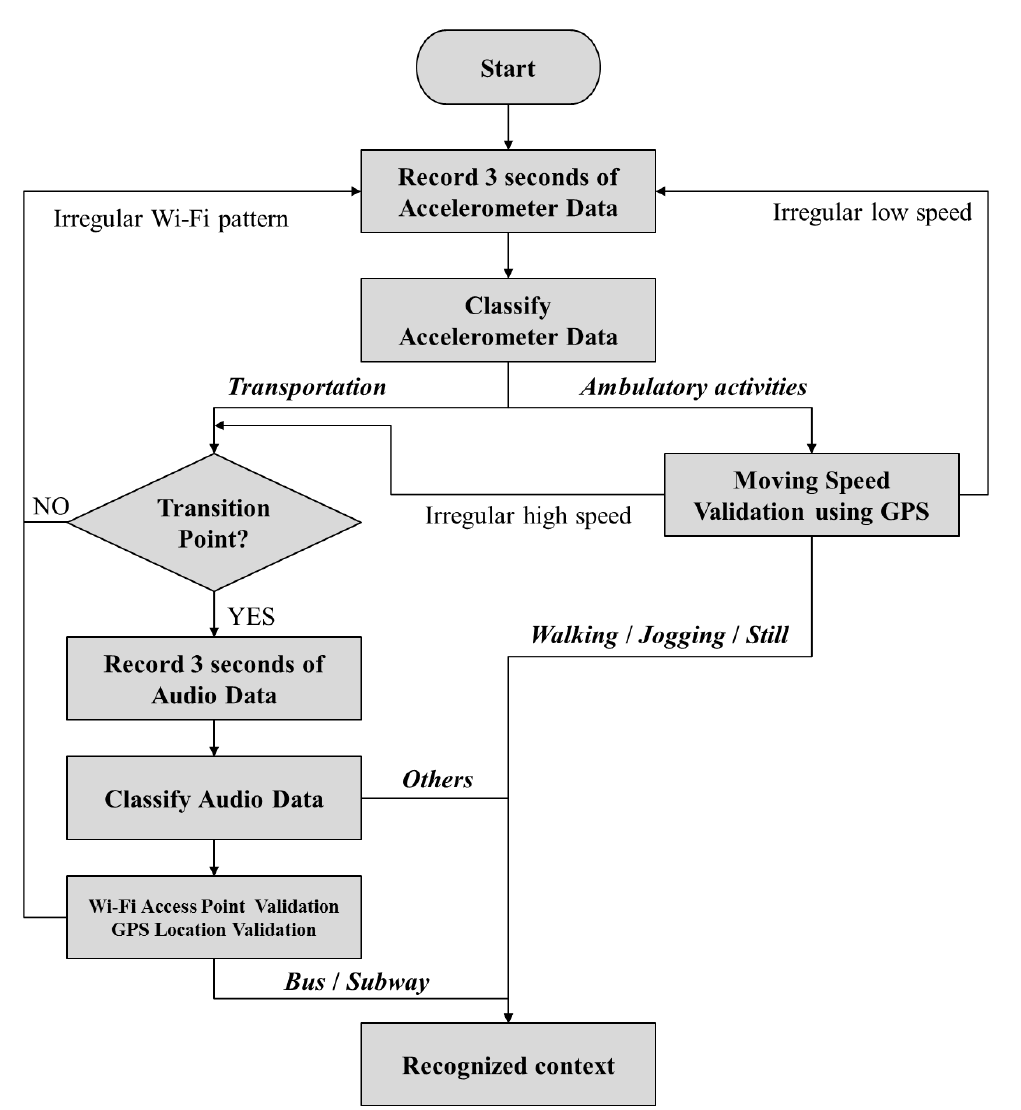
Figure 2. Flow chart of the proposed